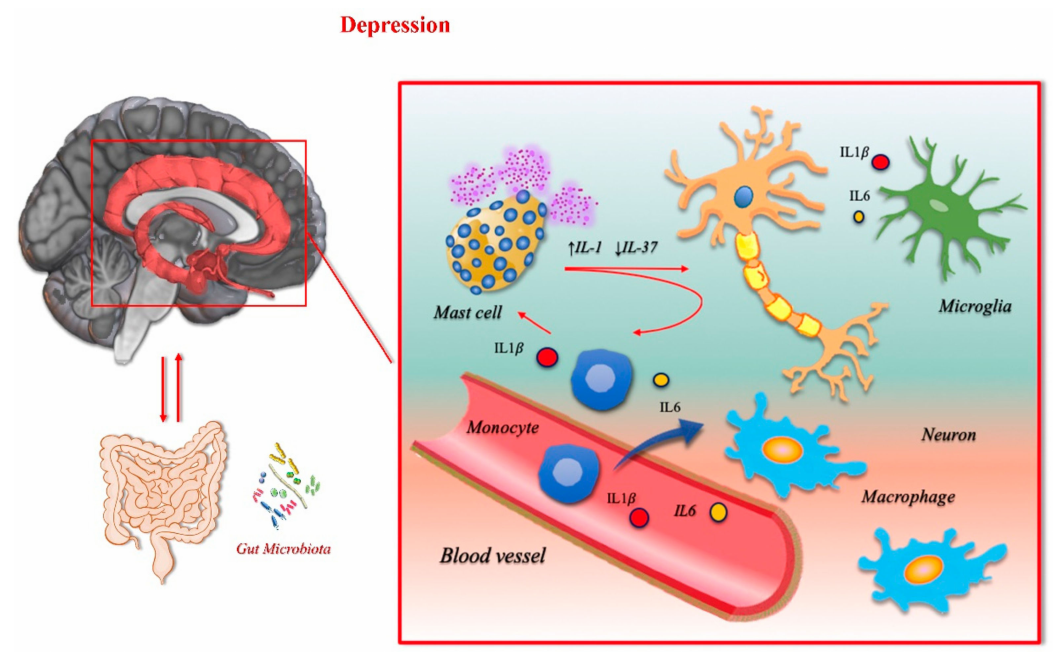
Figure 6. The immunological mechanisms associated with